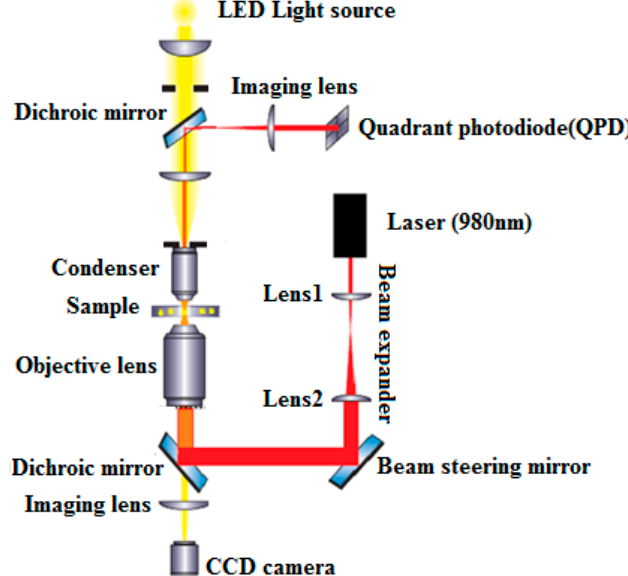
Figure 1. Setup scheme used for experiments.